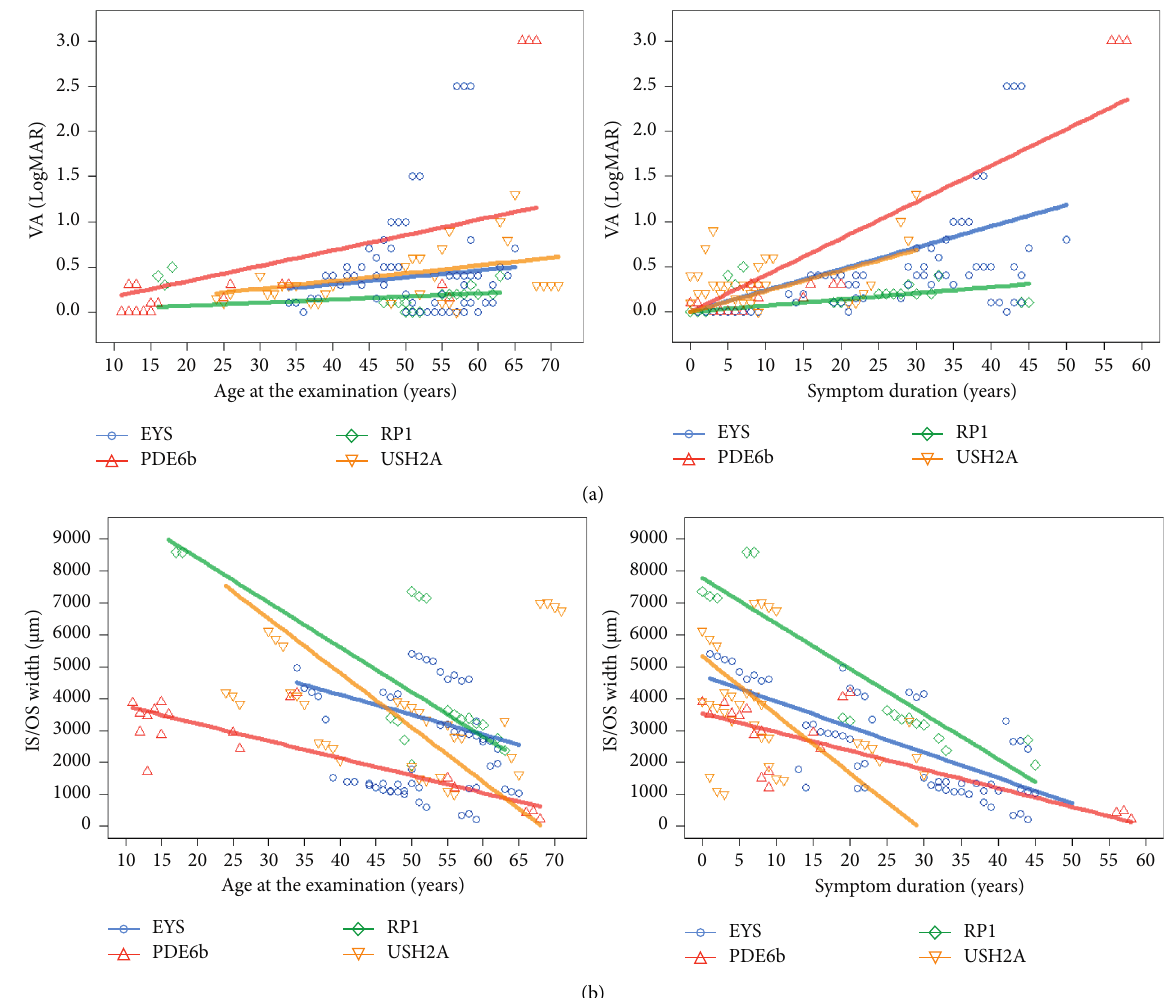
Figure 3: Changes in the visual acuity and photoreceptor layers in the patients with retinitis pigmentosa carrying variants of four causative genes during the follow-up periods. Changes in the (a) visual acuity and (b) width of the photoreceptor layers during the follow-up periods. The trend lines were drawn based on the patients’ ages at the time of the examination and the symptom duration (defined as the period from the first symptoms to the age of the patient at the time of the examination). VA, visual acuity; LogMAR, logarithm of the minimum angle of resolution; IS/OS, photoreceptor inner segment/outer